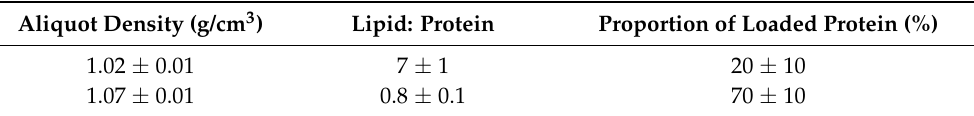
Table 3. Fractions of KcsA and DOPE–DOPS–Rhod-PE proteoliposomes from isopycnic sucrose gradient